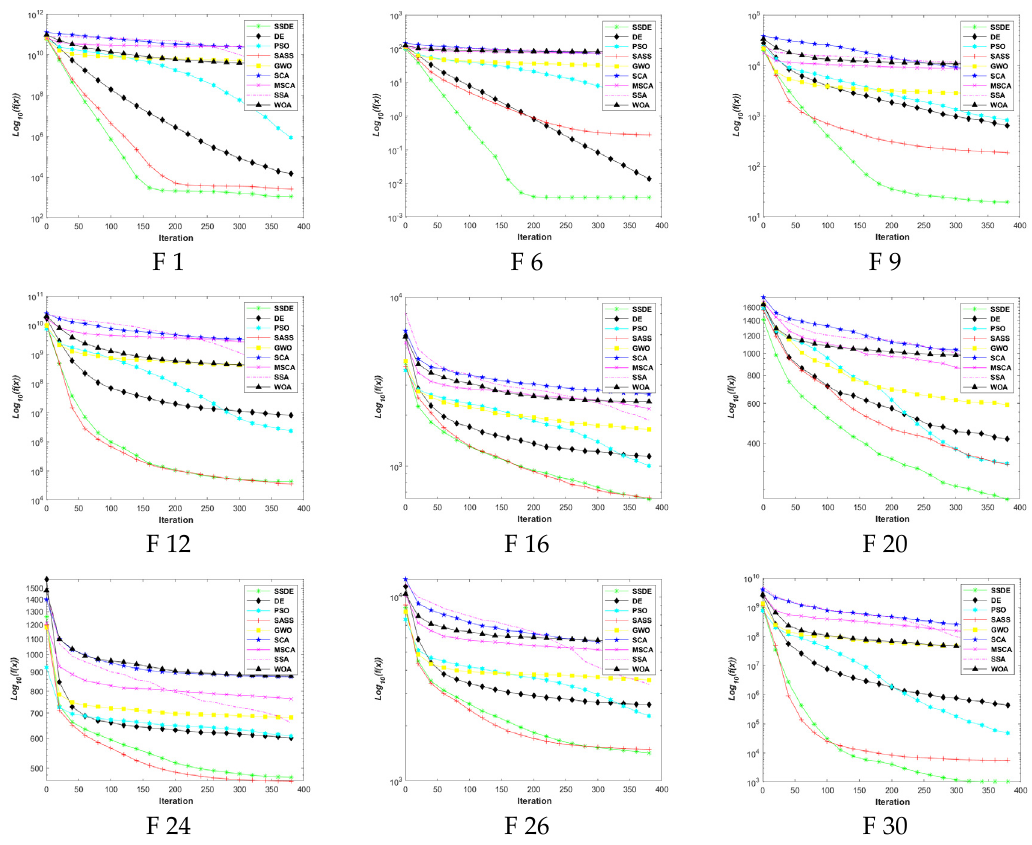
Figure 5. Evolutionary curves of SSDE, DE, PSO, SASS, GWO, SCA, MSCA, SSA, and WOA on the CEC 2017 test functions in 30 dimensions.